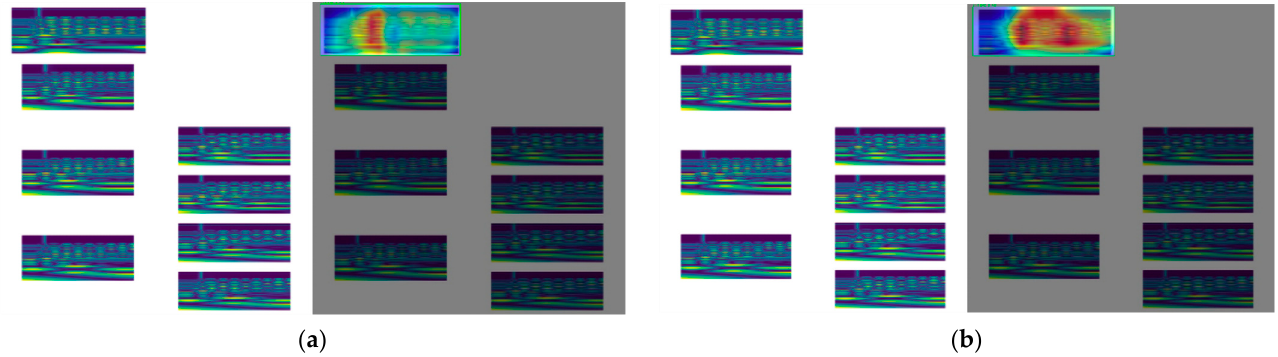
Figure 20. Neural network heat map before and after adding the attention mechanism: ( a ) no attention mechanism added; ( b ) add attention mechanism. Table 3. Comparison of results before and after adding the CA attention mechanism.